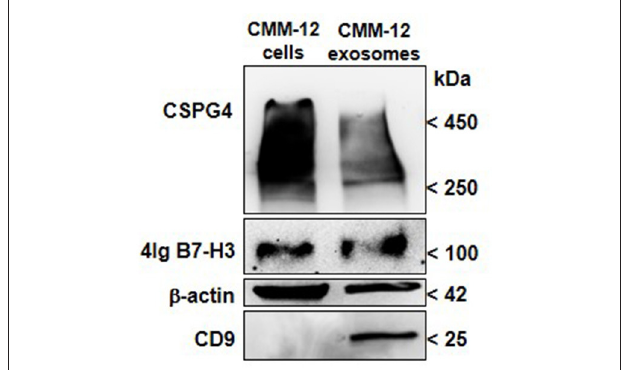
FIGURE 2 | CSPG4 and B7-H3 expression in canine-OMM-cell-derived SEVs. EX purification columns (Exo-spin Midi-Columns, Cell Guidance System, Cambridge, UK) were used to purify enriched EX-SEVs from the supernatant of fetal bovine serum-deprived CMM-12 cells. Briefly, the collected media was centrifuged to remove any cell debris and then incubated with the Exo-Spin Buffer to precipitate SEVs including EX and purified using Exo-Spin midi-column. Eluted SEVs were then ultracentrifuged at 100,000 x g and the pellet was resuspended in RIPA buffer for protein extraction. Representative immunoblot of CSPG4 and B7-H3 of lysates of SEVs is shown. Western Blot analysis for CSPG4 was performed as described in (73), mAb 376.96 was used for B7-H3 detection. CD9 (10626D; Thermo-Fisher Scientific) was used as the SEVs marker and β -Actin (AC-15; Santa Cruz Biotechnology) was used as the protein-loading